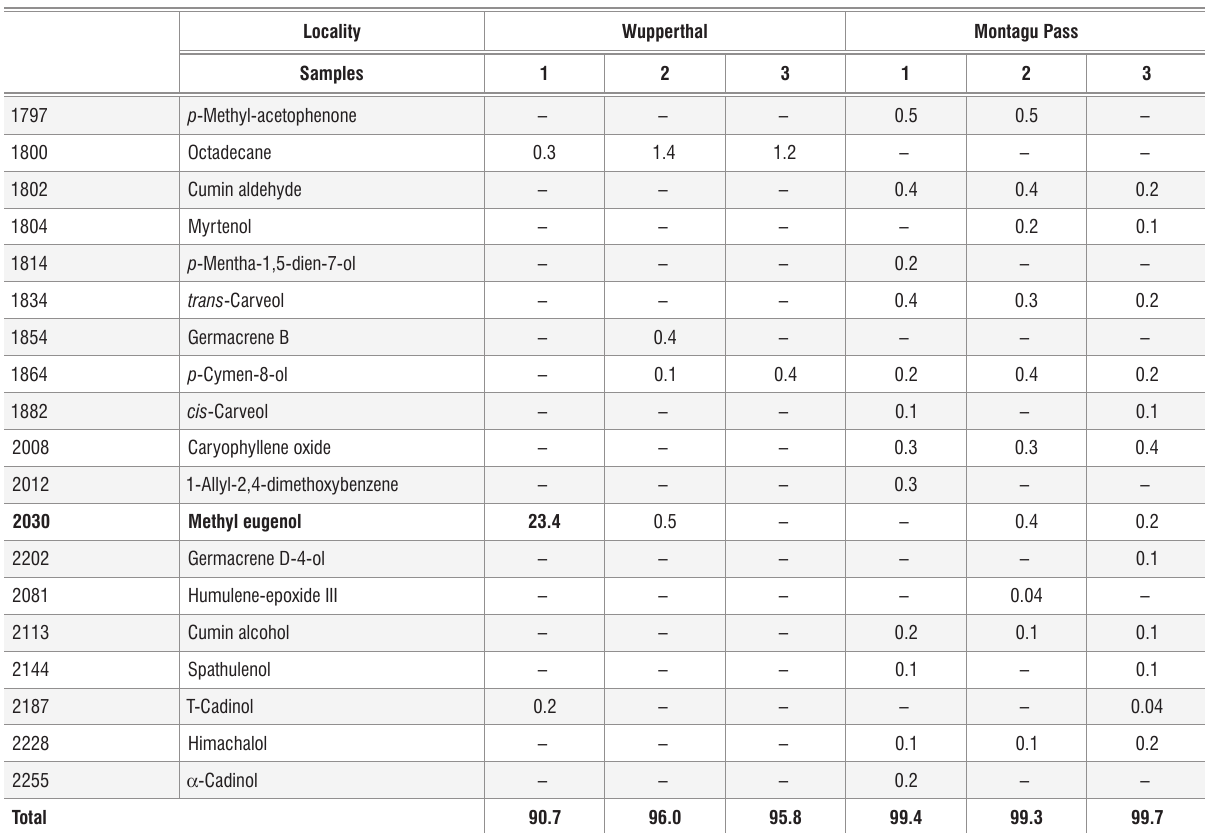
Minimum inhibitory concentrations for extracts and essential oils of three specimens of Pteronia camphorata var. armata